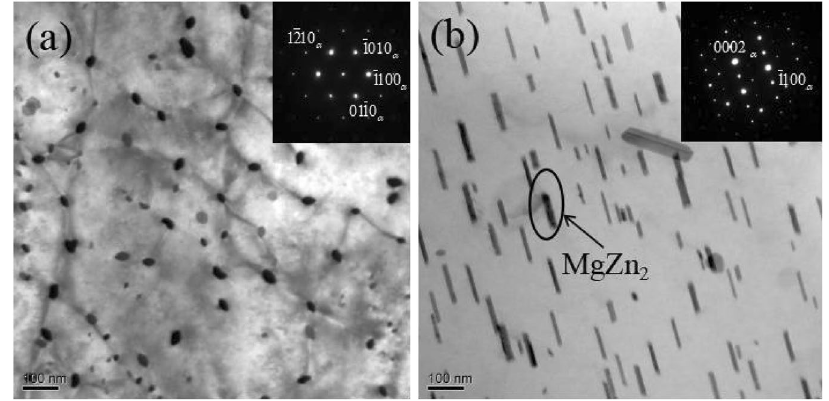
Figure 9. Bright-field TEM images of Mg-3Zn alloys in the ( a ) [0001] and ( b ) [1120] direction of α -Mg.